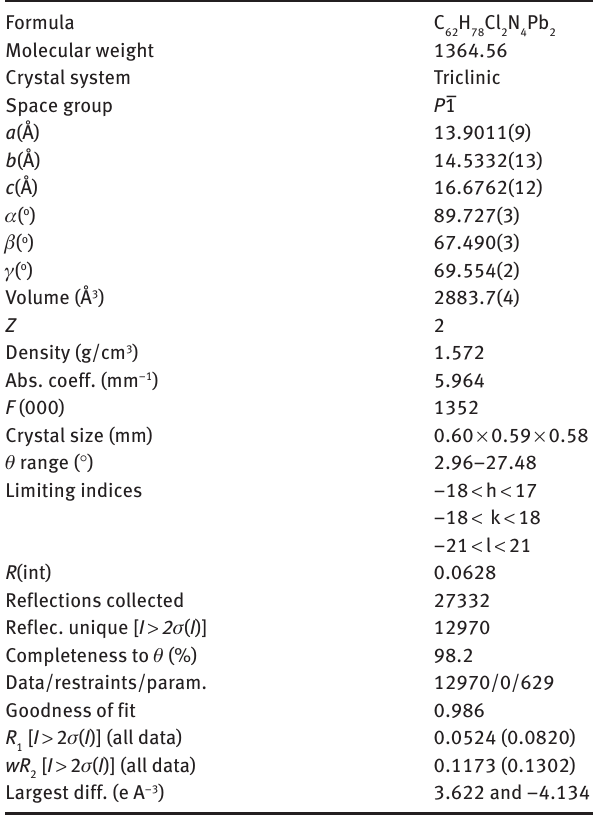
Table 2: Summary of crystallographic data for [{N^N iPr }Pb( μ -Cl)] ( 1 , CCDC no.